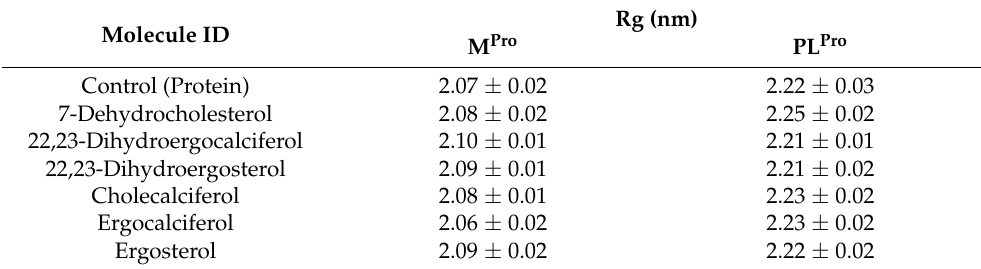
Table 4. Mean and standard deviation of Rg of Mpro and PLpro in apo and ligand-bound states.